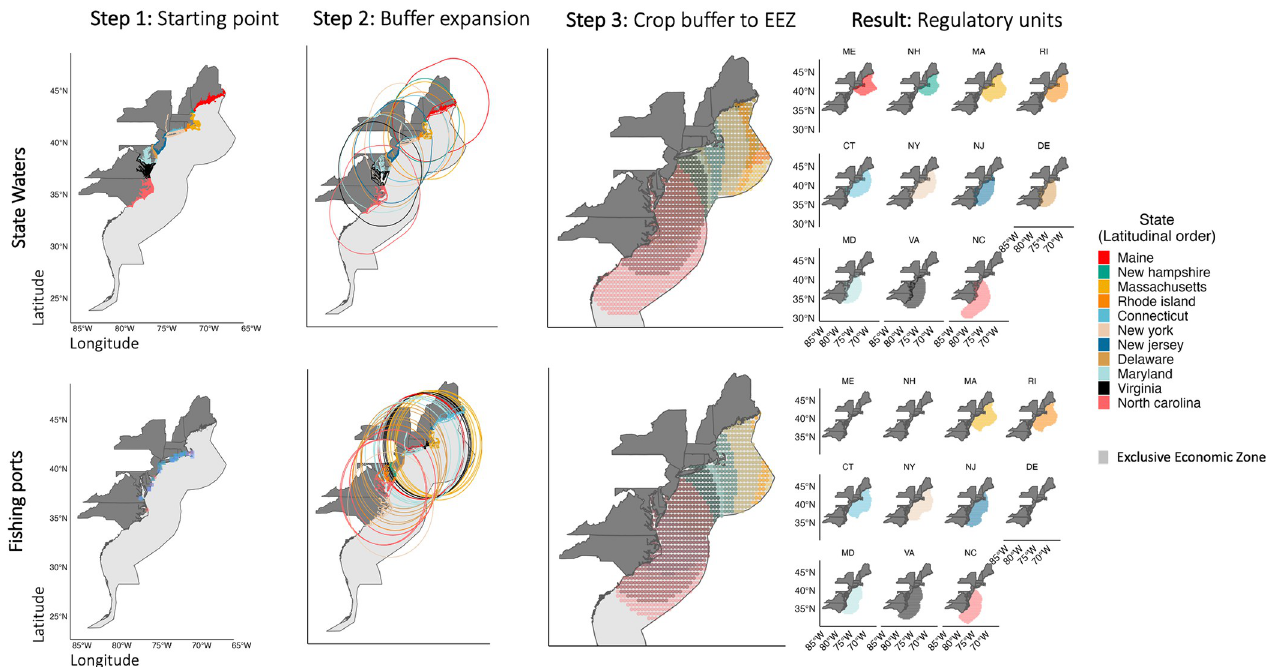
Fig 2. Graphical description of the method employed to design the regulatory units. Top row represents the state waters approach. Bottom row represents the fishing ports approach. Both approaches follow the same methods according to each column title. Colors represent each state’s expanded regulatory unit in each time step. Step one is the starting point (state waters top; fishing ports bottom), step two shows the expanded buffer from the starting point, step three shows that same buffer cropped to the EEZ (note that the area of each state’s cropped buffer is shaded), the result shows the final regulatory unit by state (similar to step 3 but